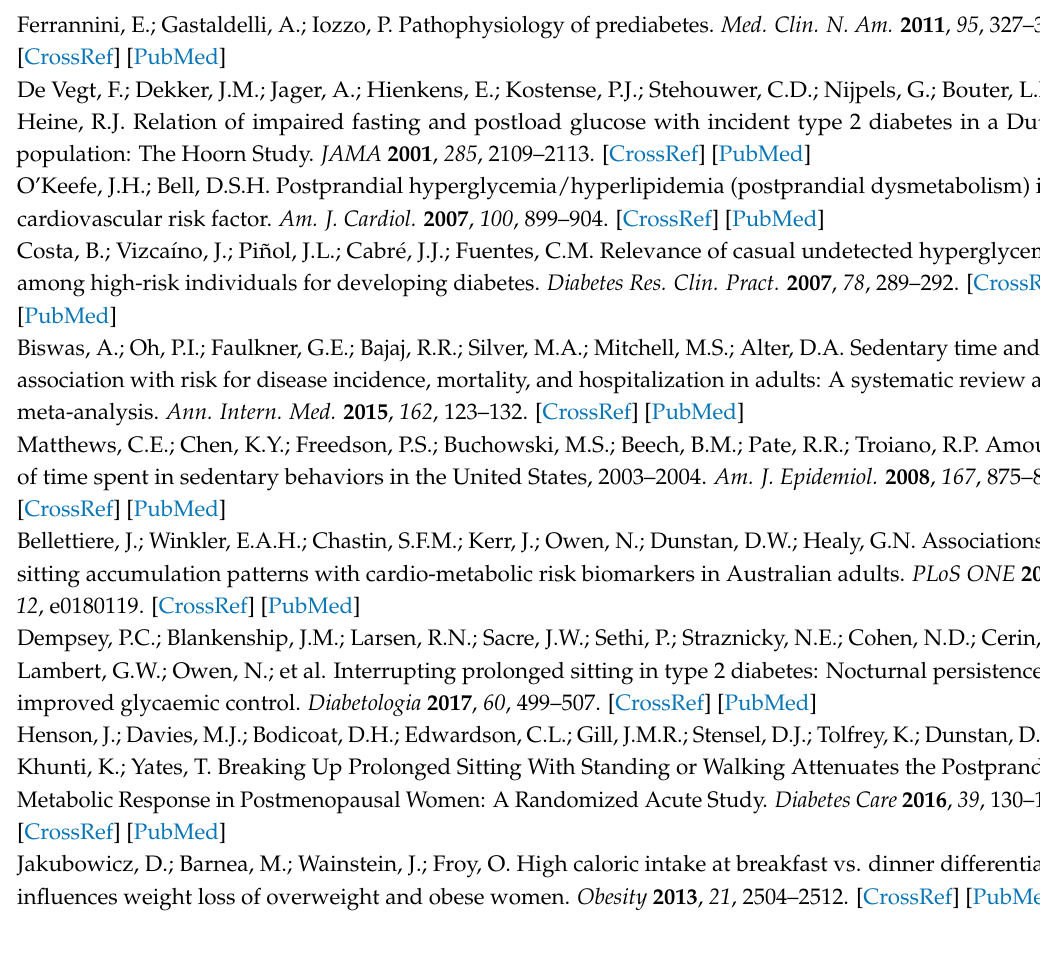
Table S1: Meal composition and nutritional values for a 10900 kJ (~2600 kcal) example diet for each condition, File S1: CONSORT